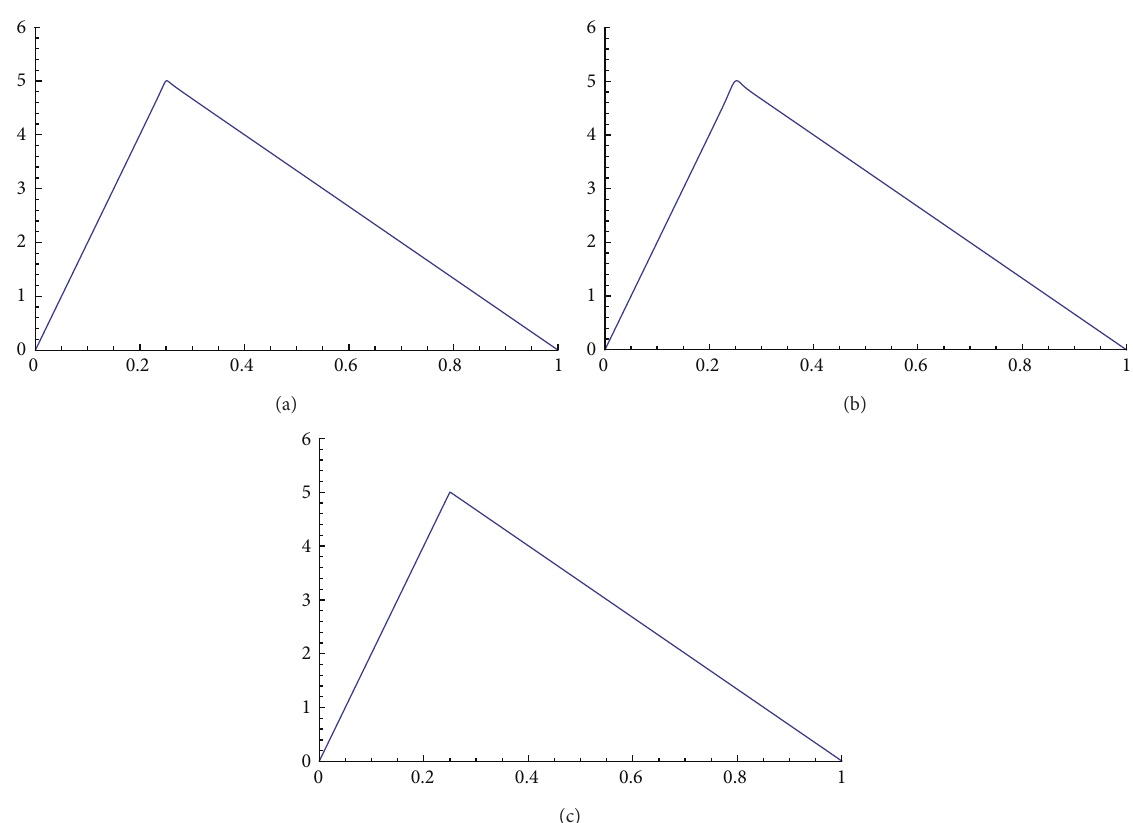
Figure 4: Straight lines 𝐿 𝑖 (𝑢) and 𝐿 𝑖+1 (𝑢) joined by first-, second, and third-step function representations, respectively, for 𝑖 = 1 , 𝑙 = 20 , = 0.25 , 𝜖 = 0.01 , and 𝑘 = 5 𝑢 𝑖